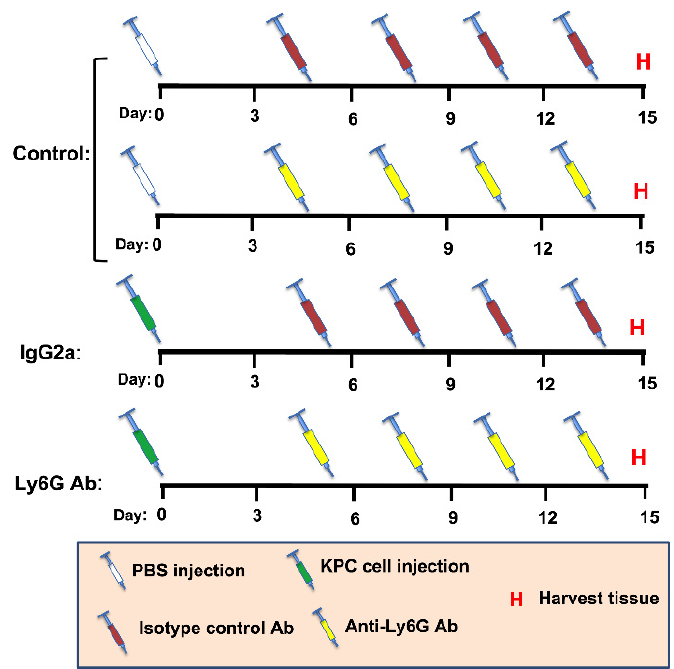
Figure 1. Schematic showing study design. Mice received an orthotopic injection of either PBS (Sham, n = 8) or KPC cells (KPC, n = 9)) into the pancreases (Day 0). Sham mice and KPC mice were then split into either an isotype control (IgG2a) group or an anti-Ly6G Ab treatment group, to deplete Ly6G-expressing cells, including granulocytic MDSCs and neutrophils. Mice were injected with either IgG2a or Ly6G Ab on day 5, 8, 11, and 14, followed by tissue harvest (H) on day 15. Based on comparable changes in body mass and muscle mass throughout study duration, Sham mice receiving IgG2a and Ly6G Ab were subsequently combined into a single control group